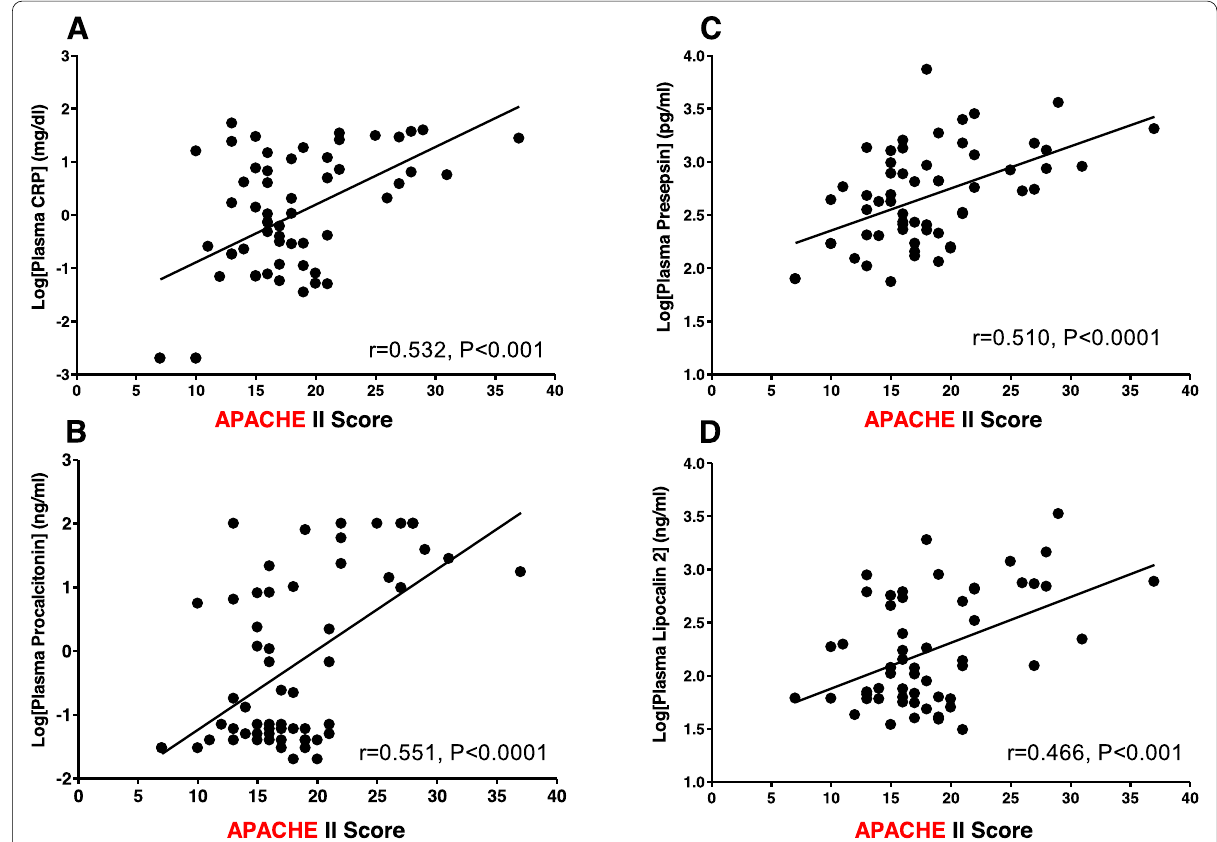
Fig. 1 There was significant correlation between APACHE II and plasma inflammatory biomarkers. A CRP. B Procalcitonin. C Presepsin. D NGAL (neutrophil gelatinase-associated